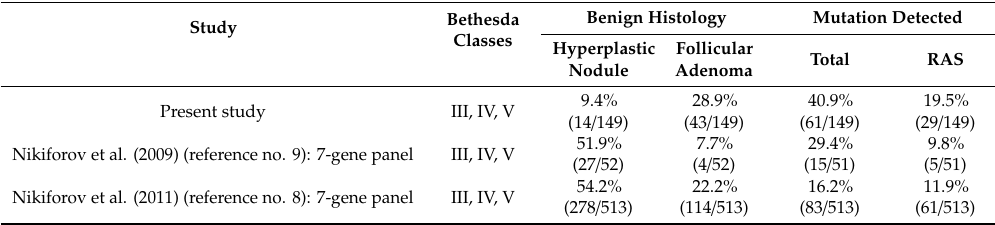
Table 4. Comparison of proportions of benign nodules and RAS -positive specimens between this study and previous studies. Benign Histology Mutation Detected Study Bethesda Classes Hyperplastic